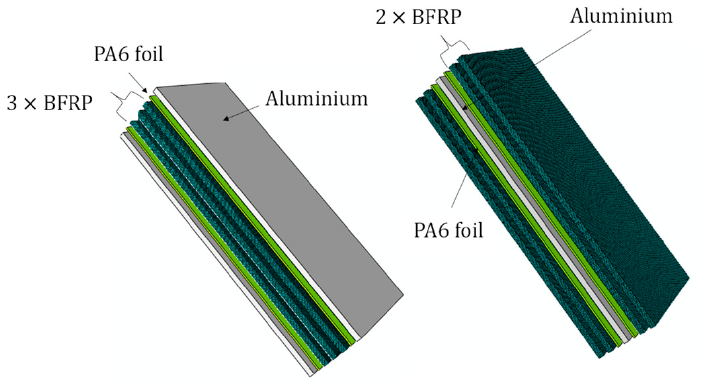
Figure 24. The BFRTP laminate structures utilised in the experiments (reproduced with permission from [295]; copyright© 2021 The Author(s). Published by Elsevier B.V.).